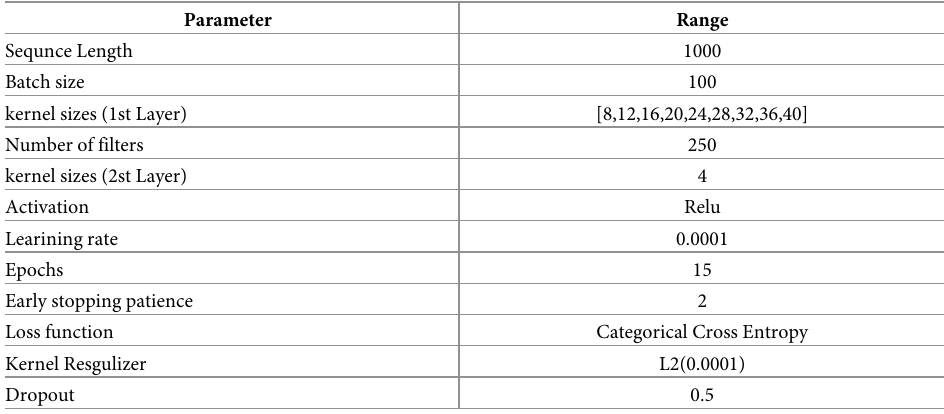
Table 2. Hyper-parameters of